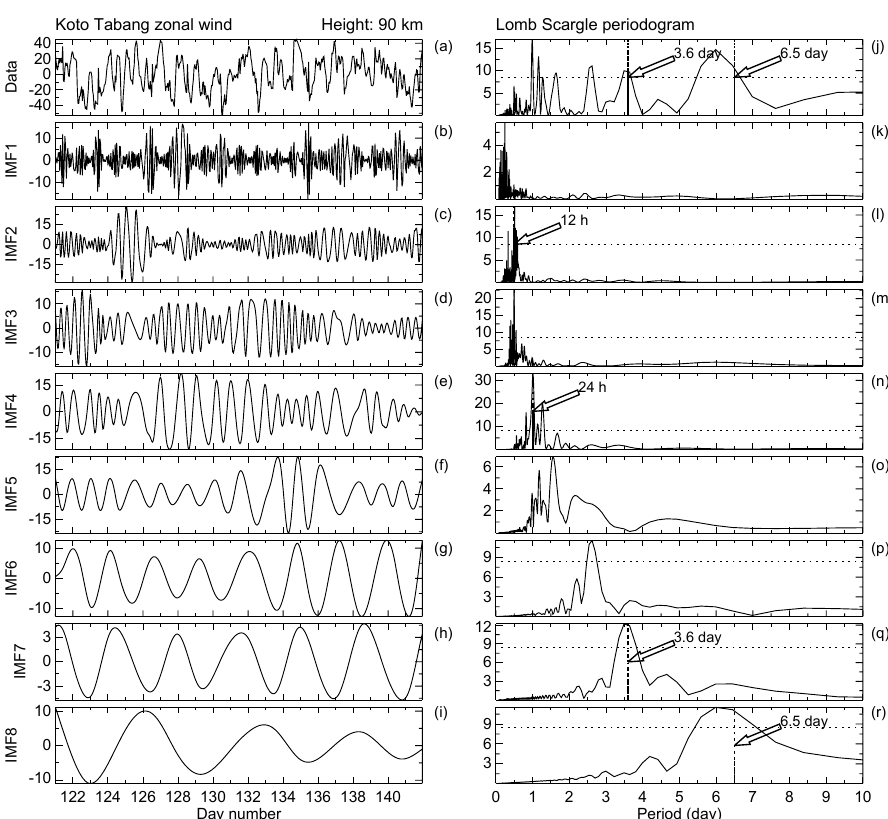
Figure 4. Time series of (a) daily mean zonal wind observed using the Kototabang radar during 1 to 21 May 2010 at the 90km altitude level. Intrinsic mode function components from the first to eighth IMFs are shown in (b–i) . Corresponding LSP are shown in (j–r) , respectively. The dashed horizontal lines in (j–r) indicate the 95% confidence